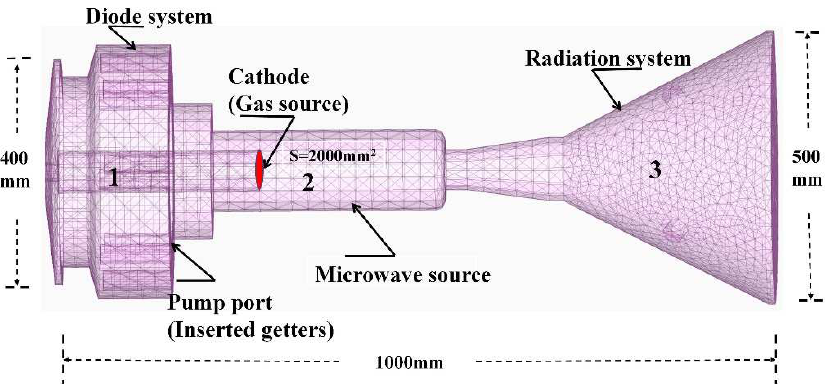
Figure 1. Schematic of dynamic pumping